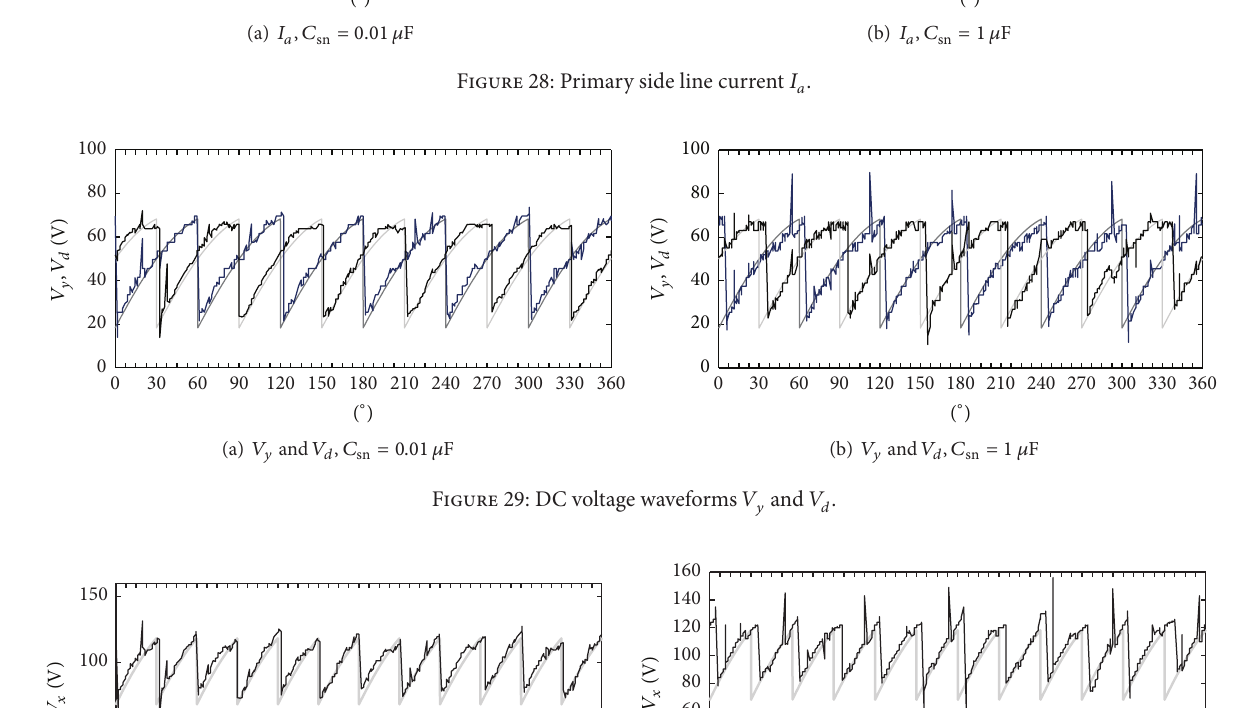
Figure 28: Primary side line current 𝐼 𝑎 .